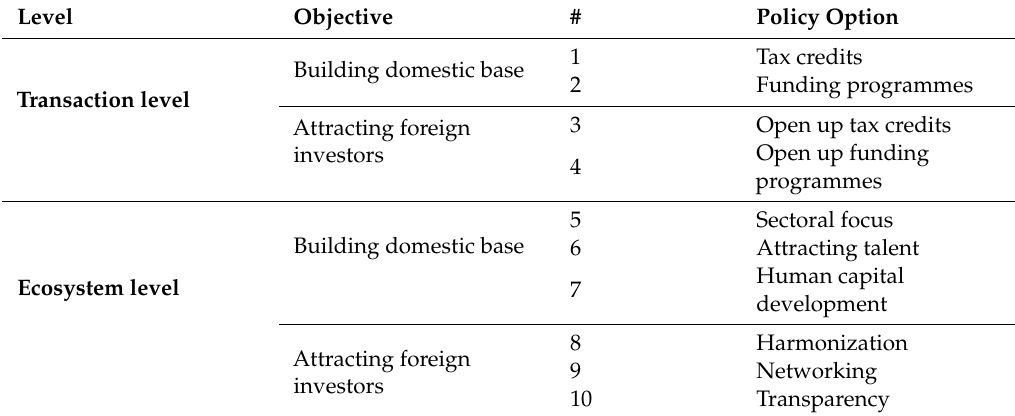
Table 4. Comparison of public policies towards cross-border